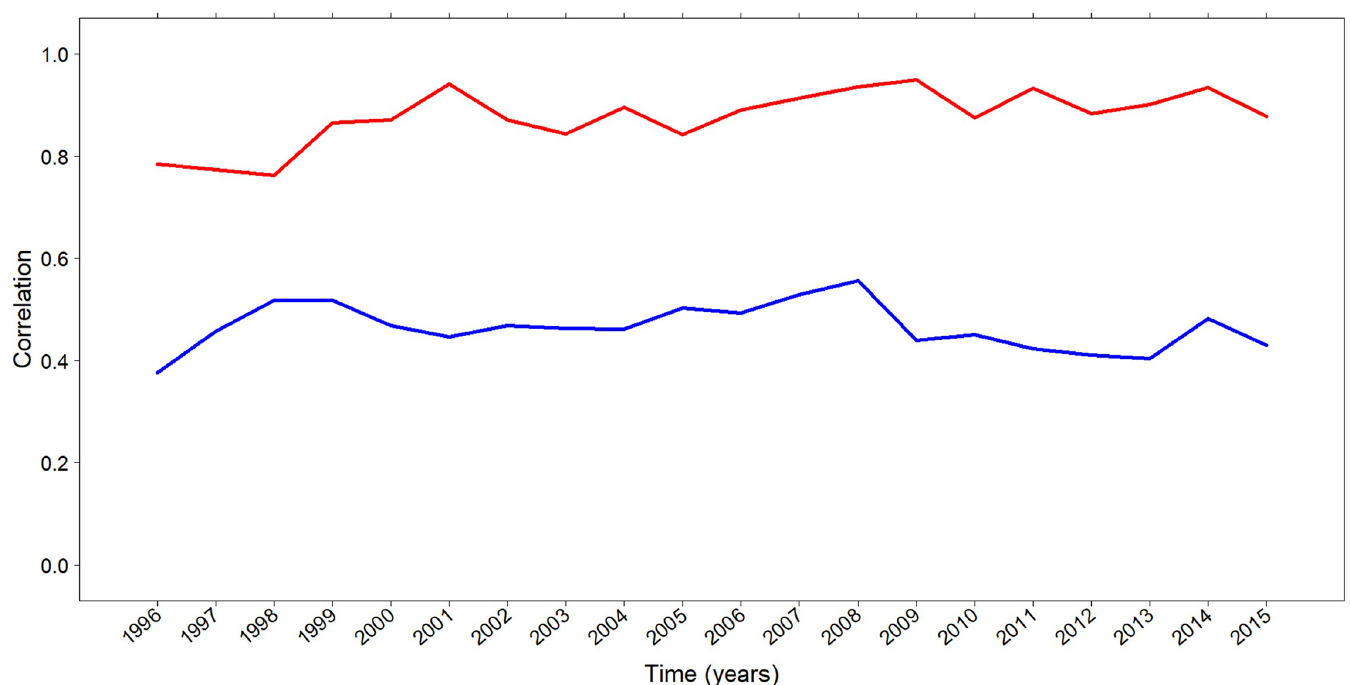
Fig 4. Transfer spending and UEFA points. Correlations between leagues’ total transfer spending and UEFA points (all clubs; blue line) and correlations between clubs’ total transfer spending and UEFA points obtained irrespective of their corresponding league (red line). Years in the x-labels correspond to the first year of the season (i.e. 1996 for 1996–1997